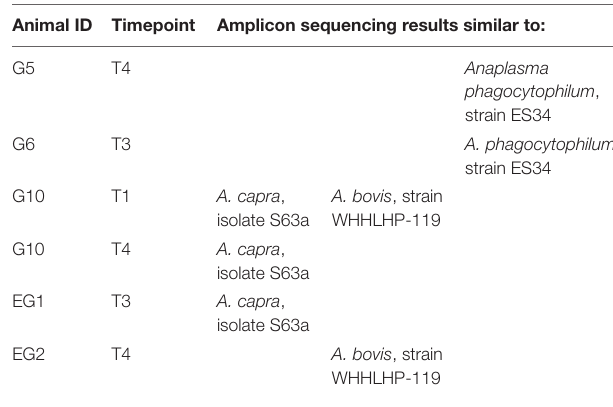
TaBle 3 | Results of matching of sequences from samples on site G (Gotland), including two blood samples from lambs showing poor growth (EG1, EG2).